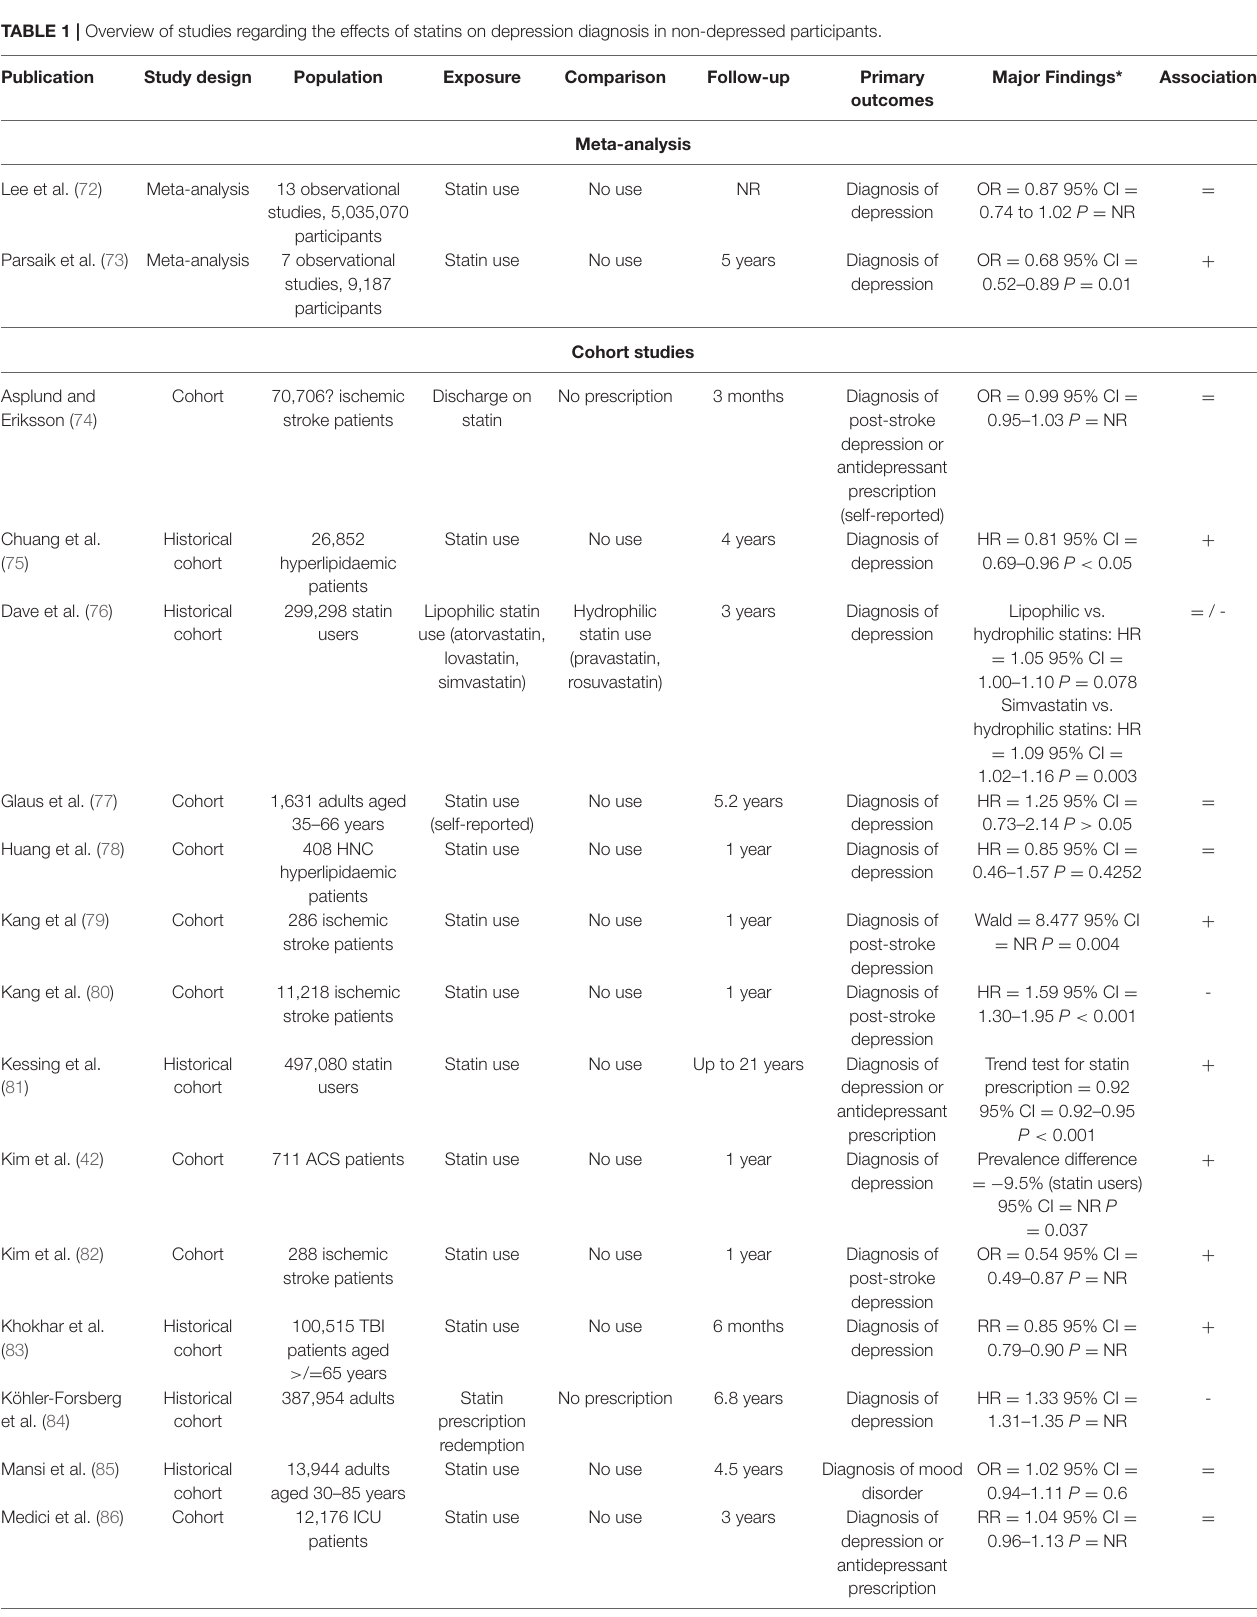
TABLE 1 | Overview of studies regarding the effects of statins on depression diagnosis in non-depressed